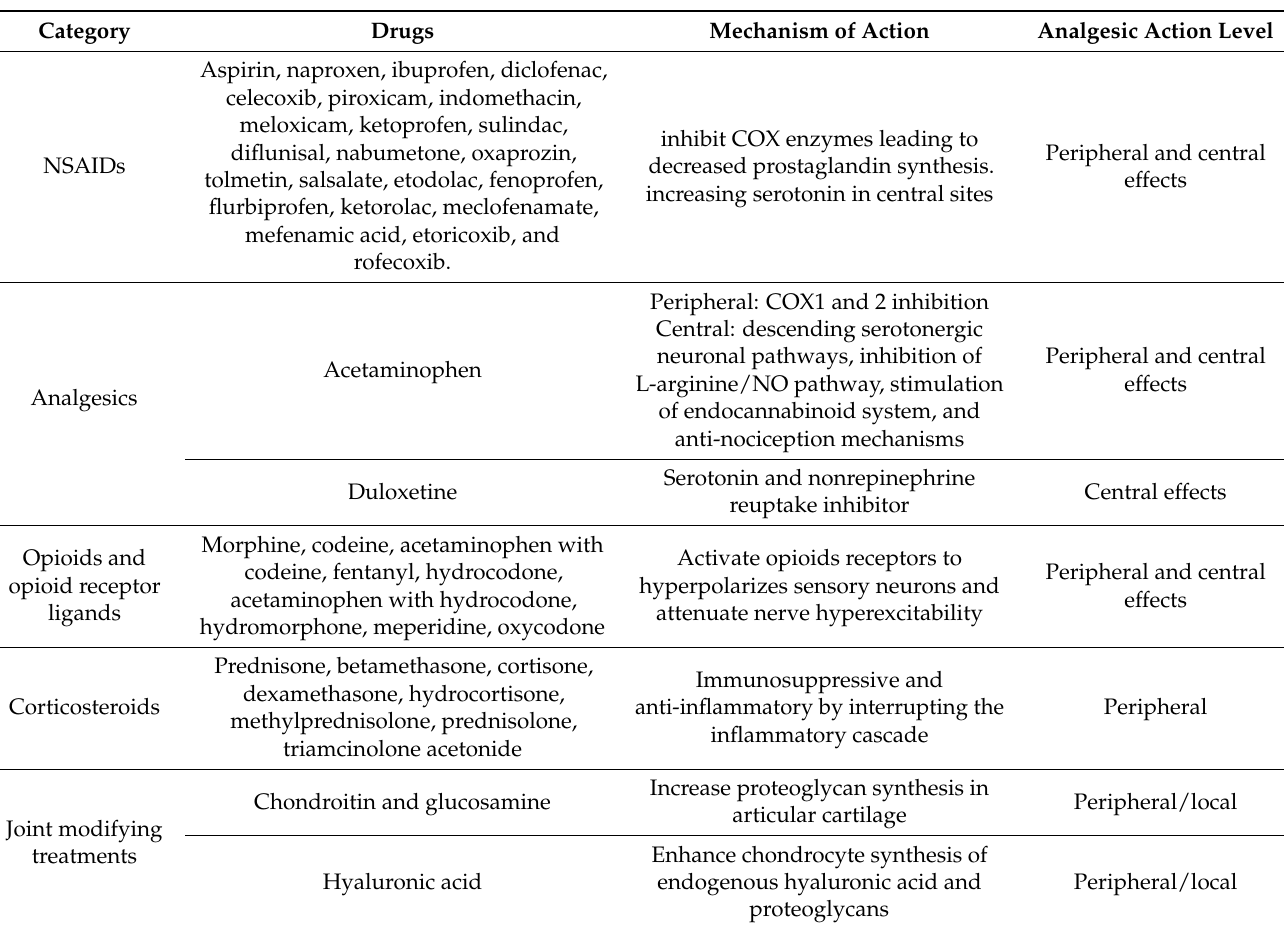
Table 8. Conventional therapeutics for